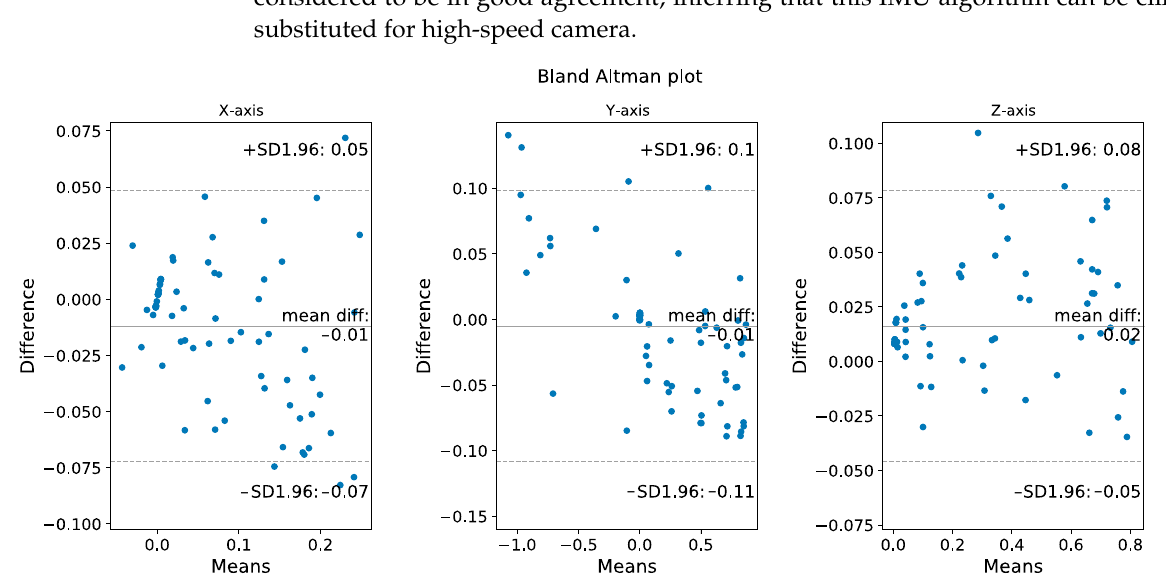
Figure 6. Validation of position during the motion by comparing the IMU algorithm results with high-speed camera results. The Bland–Altman plots for the three axes show that the data obtained by these two methods have high similarity.